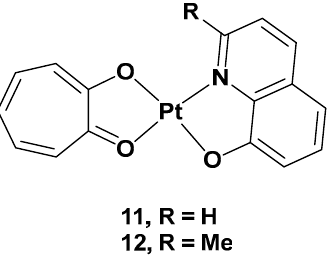
Figure 8. [Pt(Q)(L)] ( 11 ) and [Pt(MQ)(L)] ( 12 ). The cytotoxicity was tested on different cancer cell lines: HeLa, T24, A549, NCI-H460, and MGC80-3, as well as on HL-7702 (a healthy cell line). Complex 11 showed high cytotoxicity in these cell lines, especially T24 (IC 50 = 3.6 µ M), but also significant cytotoxic ac- tivity against the normal cell line, HL-7702; complex 12 showed selectivity in the tested cell lines, such as T24 and MGC80-3 (the IC 50 values were 10.3 and 5.97 μ M, respectively), and lower cytotoxicity than cisplatin in the normal cell line. Overall, complex 11 showed